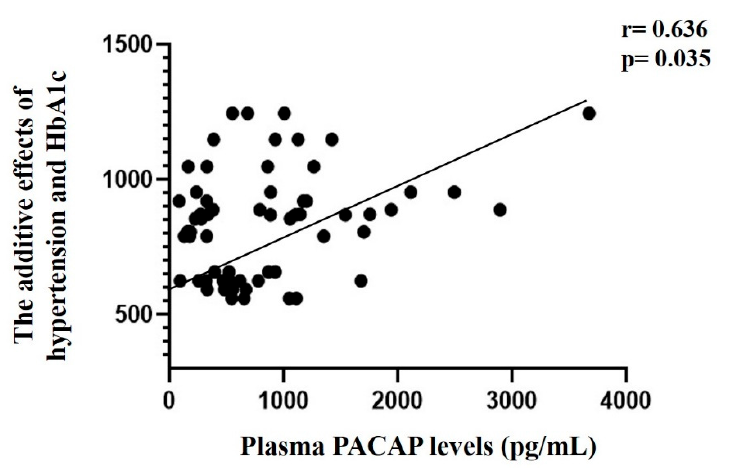
Figure 7. Connection between the additive impacting effect of hypertension and HbA1c and PACAP levels in MI patients.